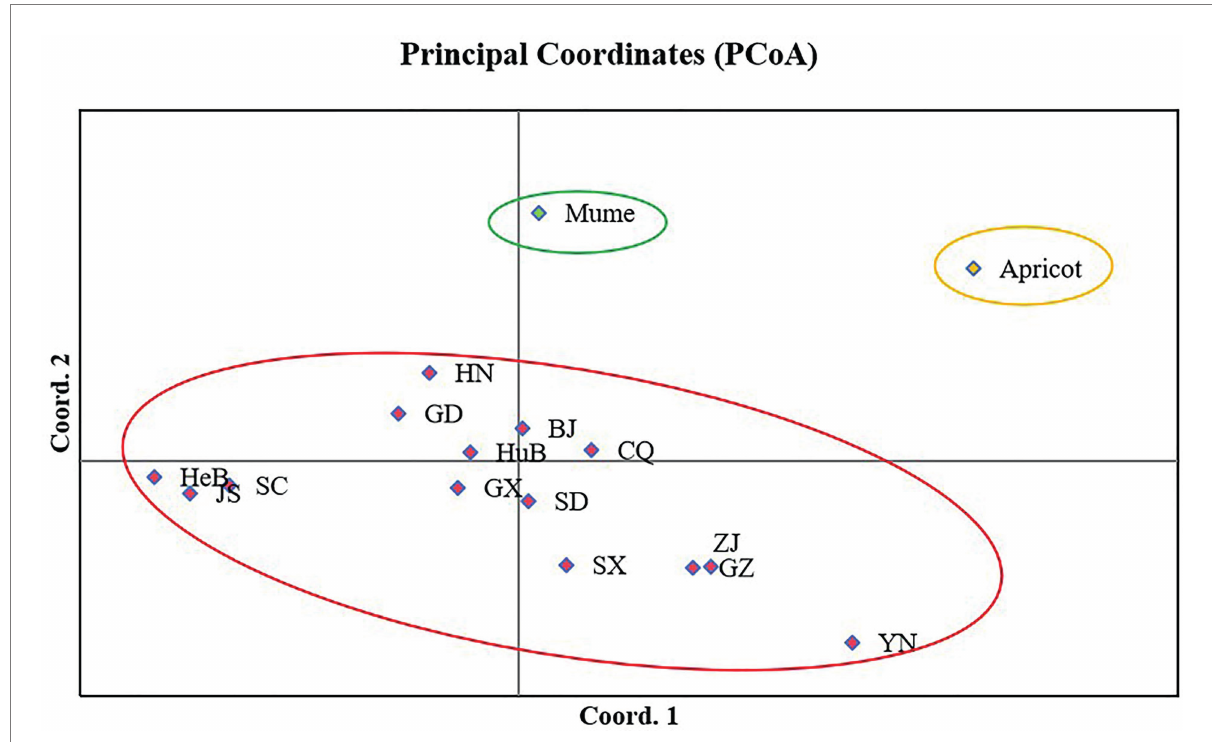
FIGURE 5 Principal coordinate analysis of 16 populations of Venturia carpophila in China based on Nei’s genetic distance using GenALEX. The red circle represents the isolates from peach, the green circle represents the isolates from mume and yellow circle represents the isolates from apricot. BJ, Beijing; CQ, Chongqing; GD, Guangdong; GX, Guangxi; GZ, Guizhou; HeB, Hebei; HuB, Hubei; HN, Henan; JS, Jiangsu; SC, Sichuan; SD, Shandong; SX, Shanxi; YN, Yunnan; ZJ,